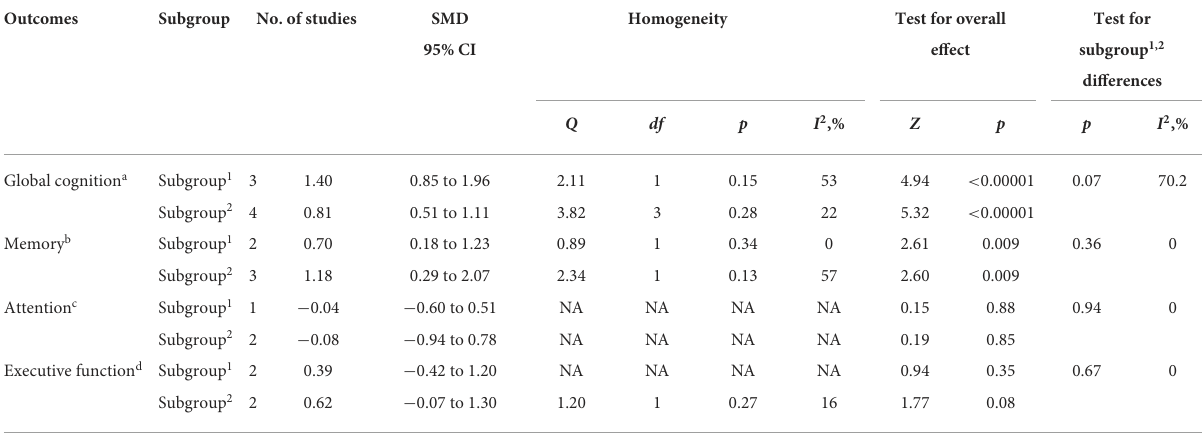
TABLE 2 Efficacy differences of combined intervention on cognition between cognitively healthy older adults and older adults with MCI after sensitive analysis. Outcomes Subgroup No. of studies SMD